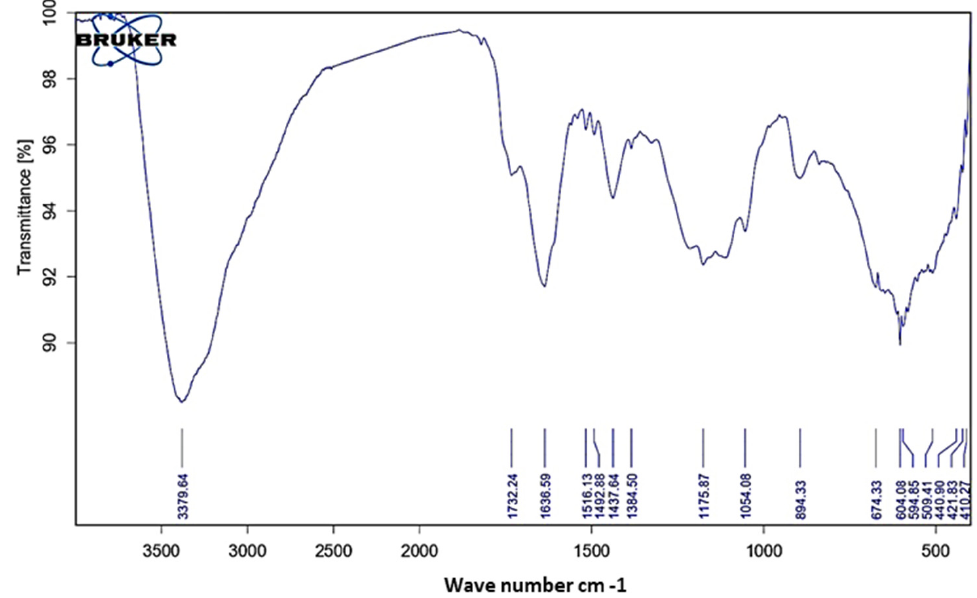
Figure 3. The FT-IR spectrum of mycosynthesized SeNPs fabricated by metabolites of A.